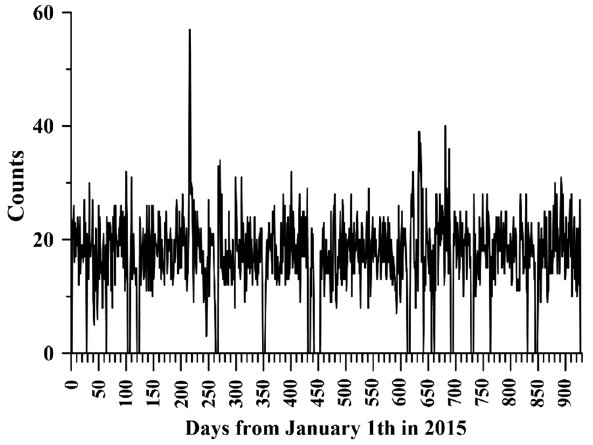
Figure 5. Daily counts of P-SV ground vibrations driving air pressure. The black line denotes the number of the P-SV waves at each frequency